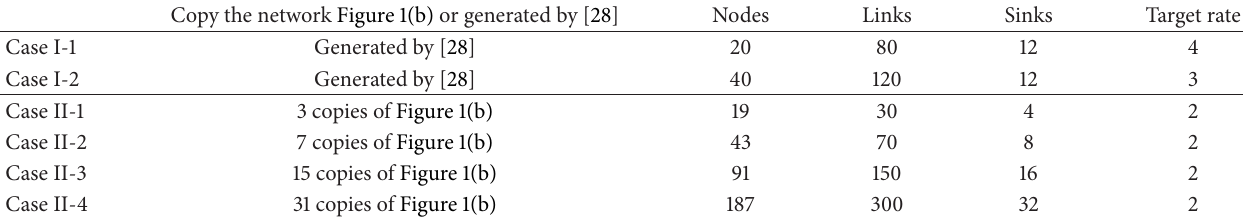
Table 1: Networks used in different test cases.